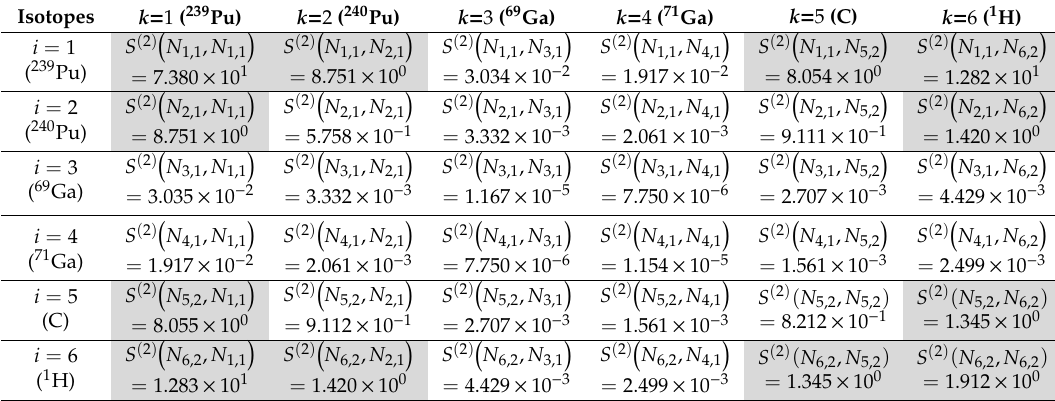
Table 2. Second-order relative sensitivities of the leakage response with respect to the isotope